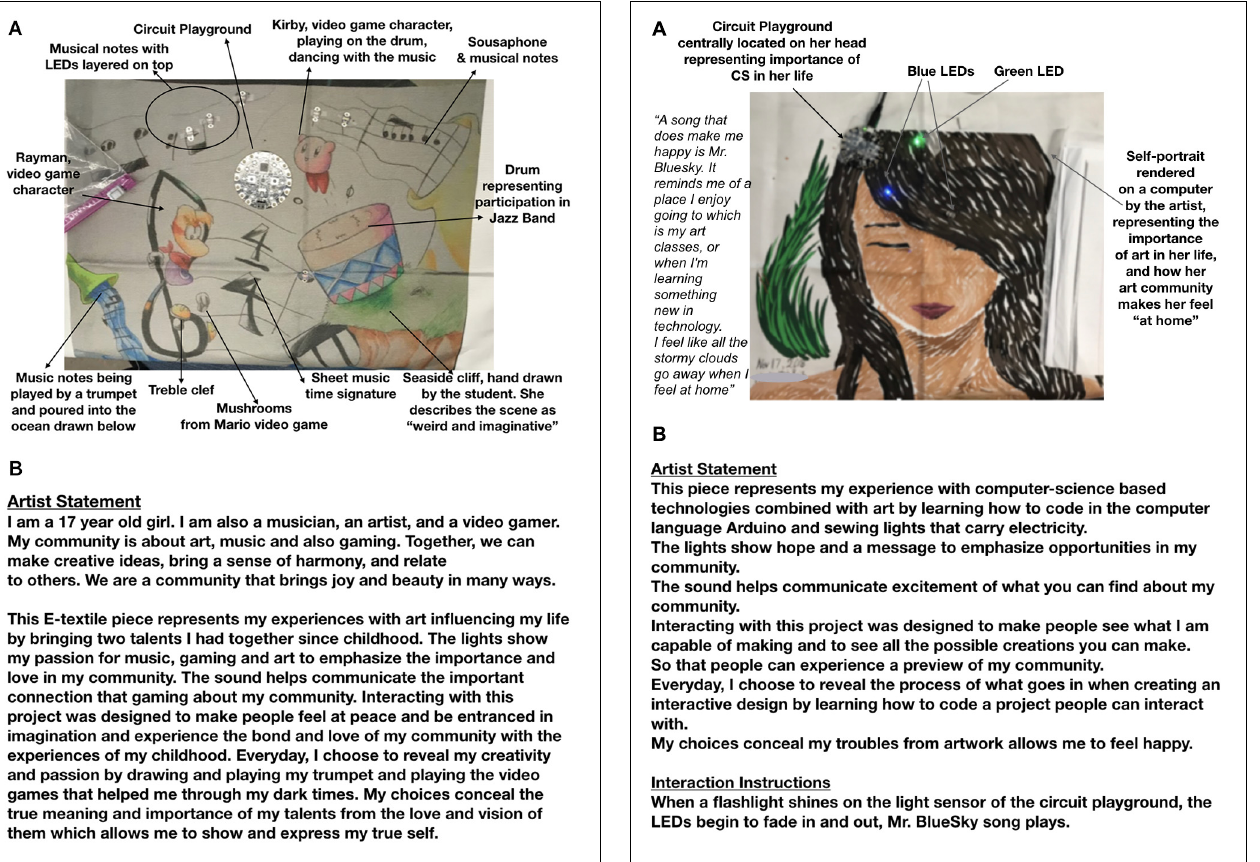
FIGURE 4 | Paloma’s Conceal/Reveal Project, Artist Statement, and Interaction